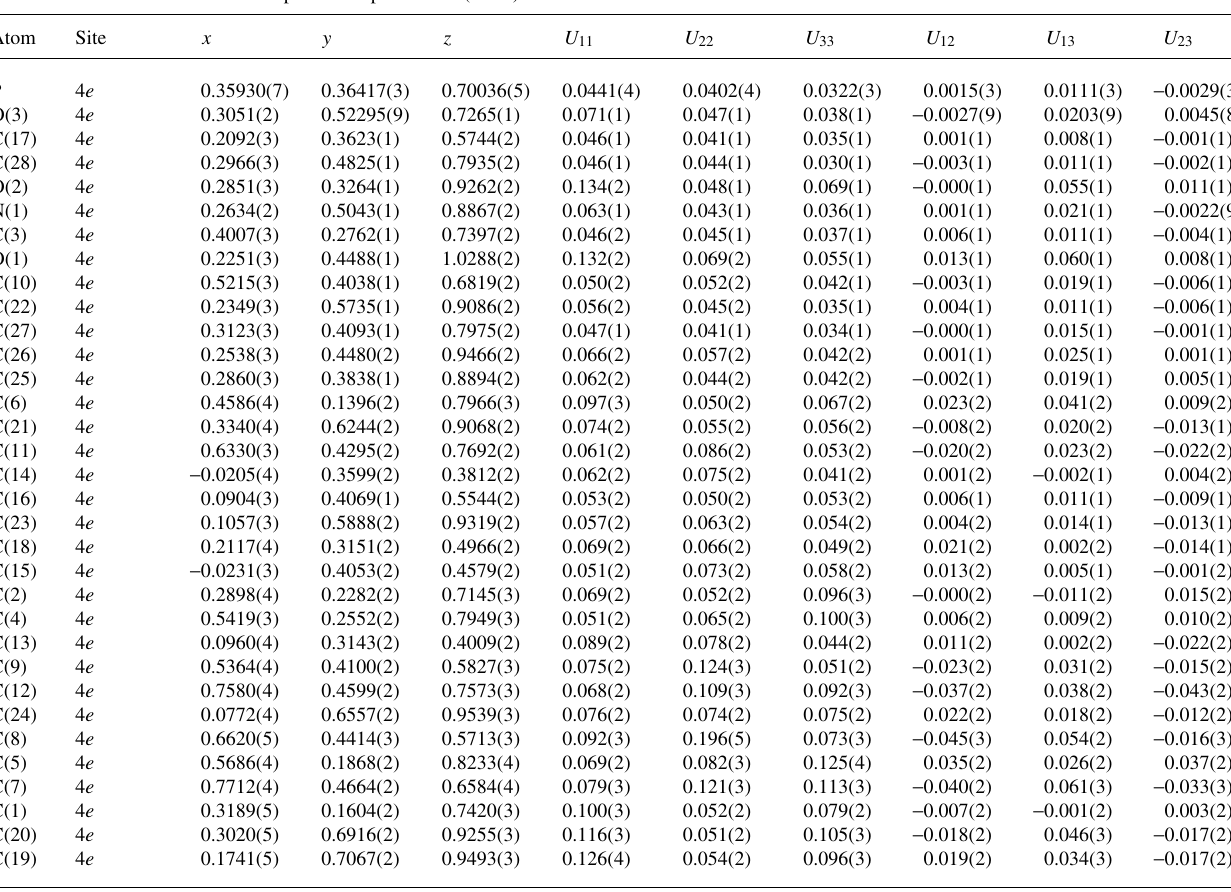
Table 3. Atomic coordinates and displacement parameters (in Å 2 )